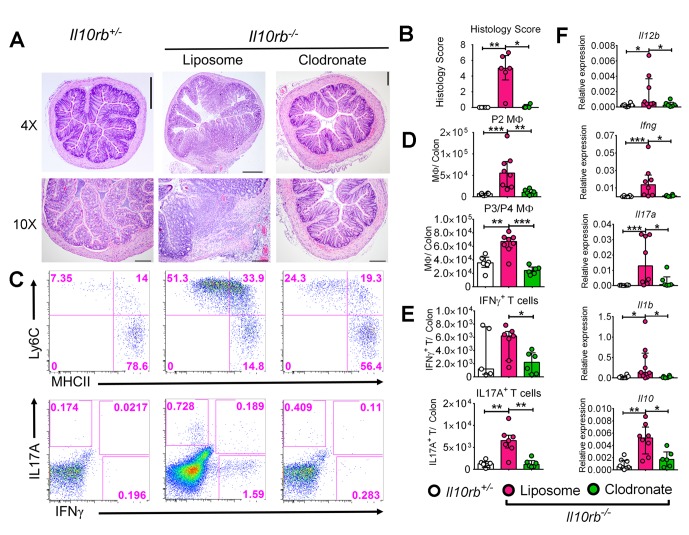
Liposomal clodronate-mediated depletion of colonic macrophages ameliorates colitis in infant Il10rb-/- mice.Three week old Il10rb-/- mice were injected intraperitoneally (i.p.) with liposomal control or liposomal-clodronate for three times within a week. (A) Representative histologic images of distal colons (4X and 10X magnification). Scale = 500 μm (4X) and 200 μm (10X). (B) Histological scores from 4 to 6 mice in each group. (C) Representative FACS plots of colonic LP MΦ subsets (upper panel) gated on CD45+CD11b+CD11cintCD103-CD64+ cells, and (lower panel) CD4+ T effector subsets following PMA and ionomycin stimulation for 4.5 hr, gated on CD45+CD3e+CD4+ T cells. Comparison of the total numbers per colon of (D) LP MΦs, and (E) CD4+ T effector cells. (F) Gene expression analysis by qRT-PCR from the colons of mice indicated above. *p<0.05, **p<0.01, ***p<0.001, Mann-Whitney U test. Data shows Median with IQR of 2 pooled experiments leading to 4–8 mice in each group.